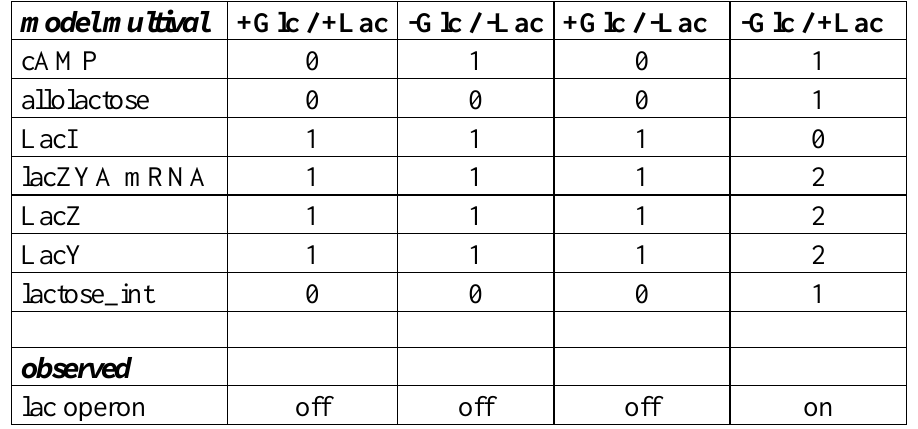
Table 4: Steady state values for the key nodes in the multivalued logic model for the 4